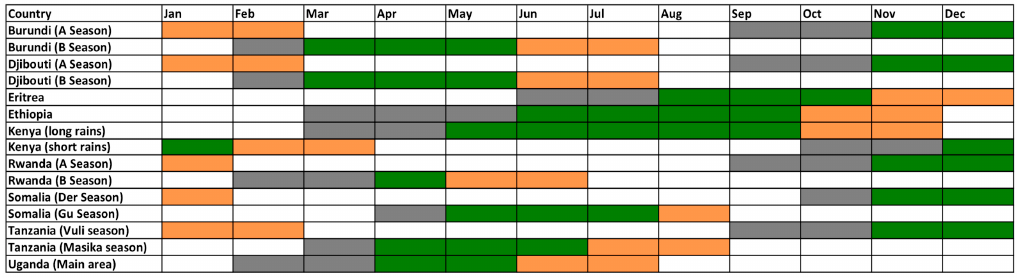
Figure 5. Sowing (grey), growing (green), and harvesting (orange) season in all nine countries (FAO GIEWS).